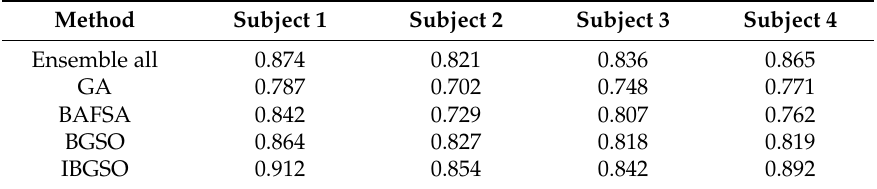
Table 12. F1 comparison of the four randomly selected subjects for the five approaches using the DSA.